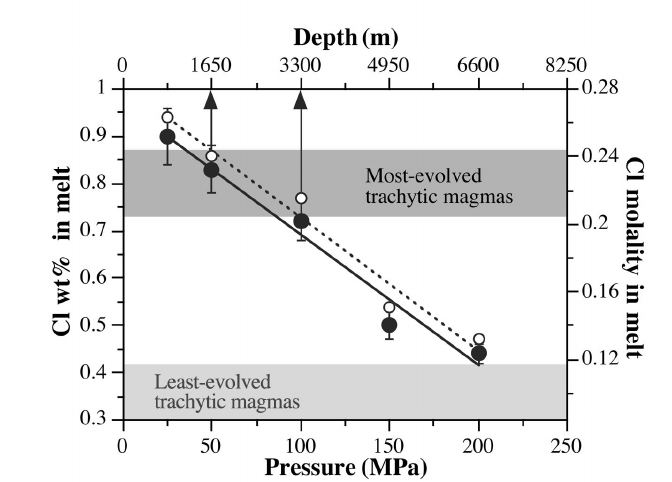
Fig. 9. Chlorine solubility in trachytic melts saturated with aqueous fluid+brine versus pressure (MPa). Solid and open circles represent original and water-free values (±1 σ standard deviation), respectively. Shaded areas represent the Cl distribution in matrix glasses (most-evolved trachytic magma) and glass inclusions (least- evolved trachytic magma). The arrows indicate the inferred depth of the CI magma chamber (from Signorelli et al. ,